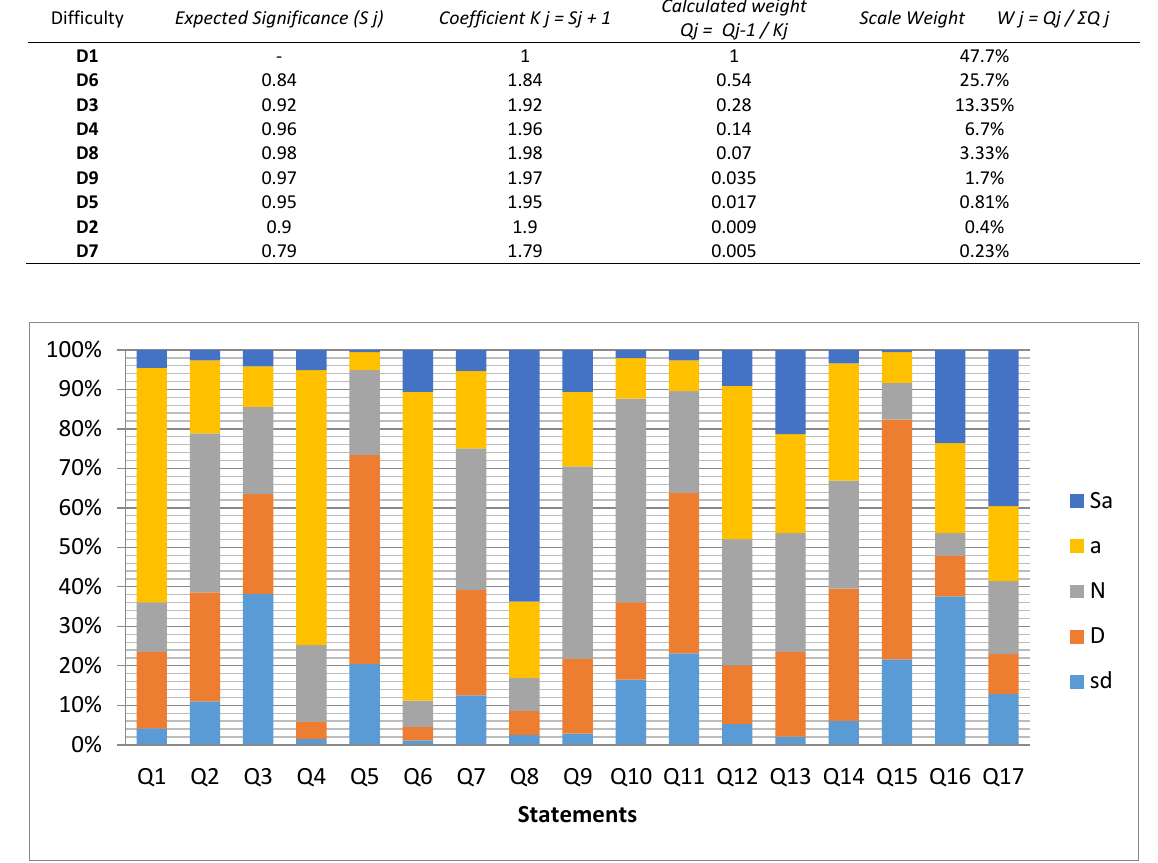
Fig. 3: Level of agreement of local workers on guanxi practices